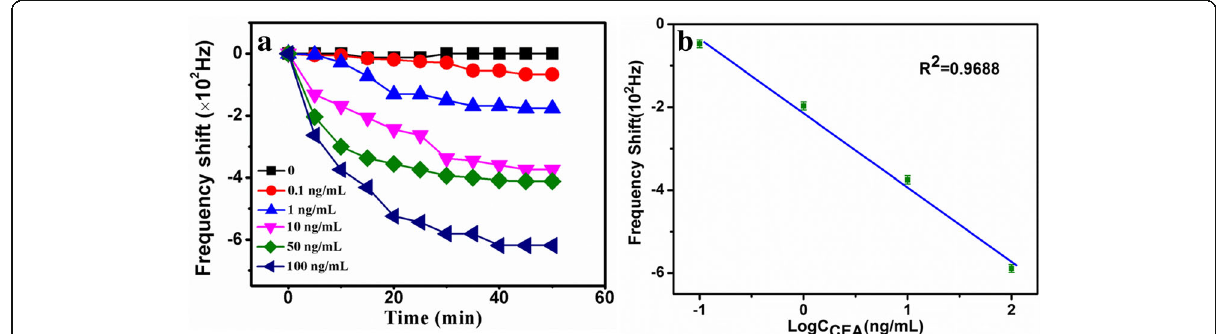
Fig. 5 Real-time response ( a ) and fitting curves ( b ) of the biosensor versus